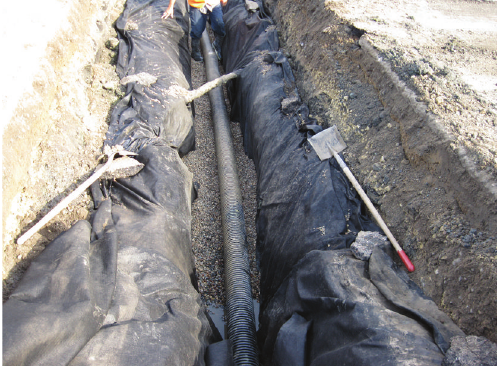
Figure 5: Photo showing installation of